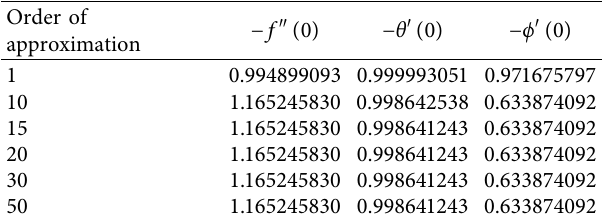
Table 1: The skin friction coefficient − f ″ ( 0 ) , the local Nusselt number − θ ′ ( 0 ) , and the local Sherwood number − ϕ ′ ( 0 ) . Order of